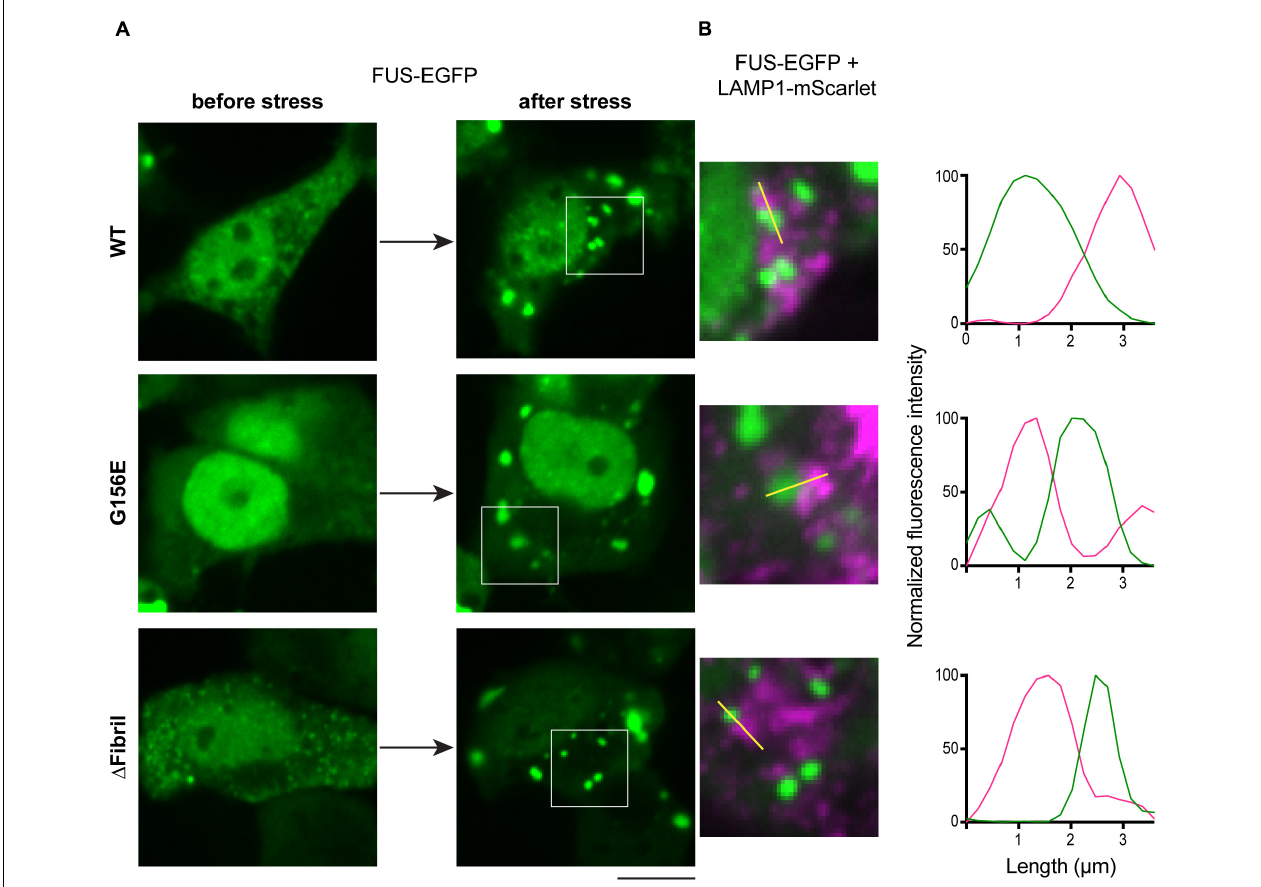
FIGURE 5 | Stress induces FUS aggregation and lysosome accumulation. (A) Cells transfected with FUS-EGFP (top), FUS-EGFP G156E (middle), and FUS-EGFP (cid:49) Fibril (bottom) imaged before (left) and after (right) incubation with sodium arsenite for 60 min. Scale bar, 10 µ m. (B) Accumulation of lysosomes (LAMP1-mScarlet) juxtaposed to FUS aggregates. Left: magnified regions from images in (A) ; right: Line profiles of the highlighted region indicated with yellow line.